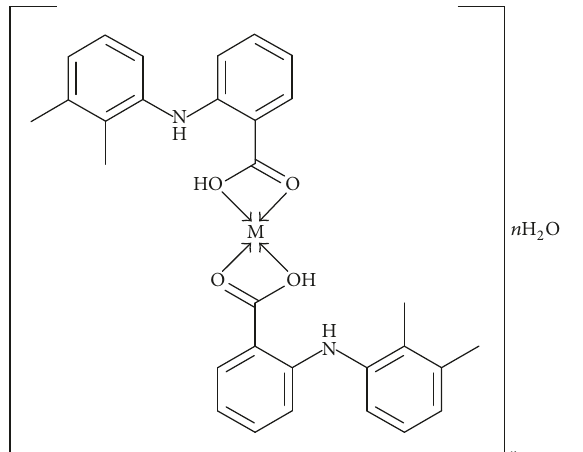
Figure 6: Proposed formula of the mefenamic-metal